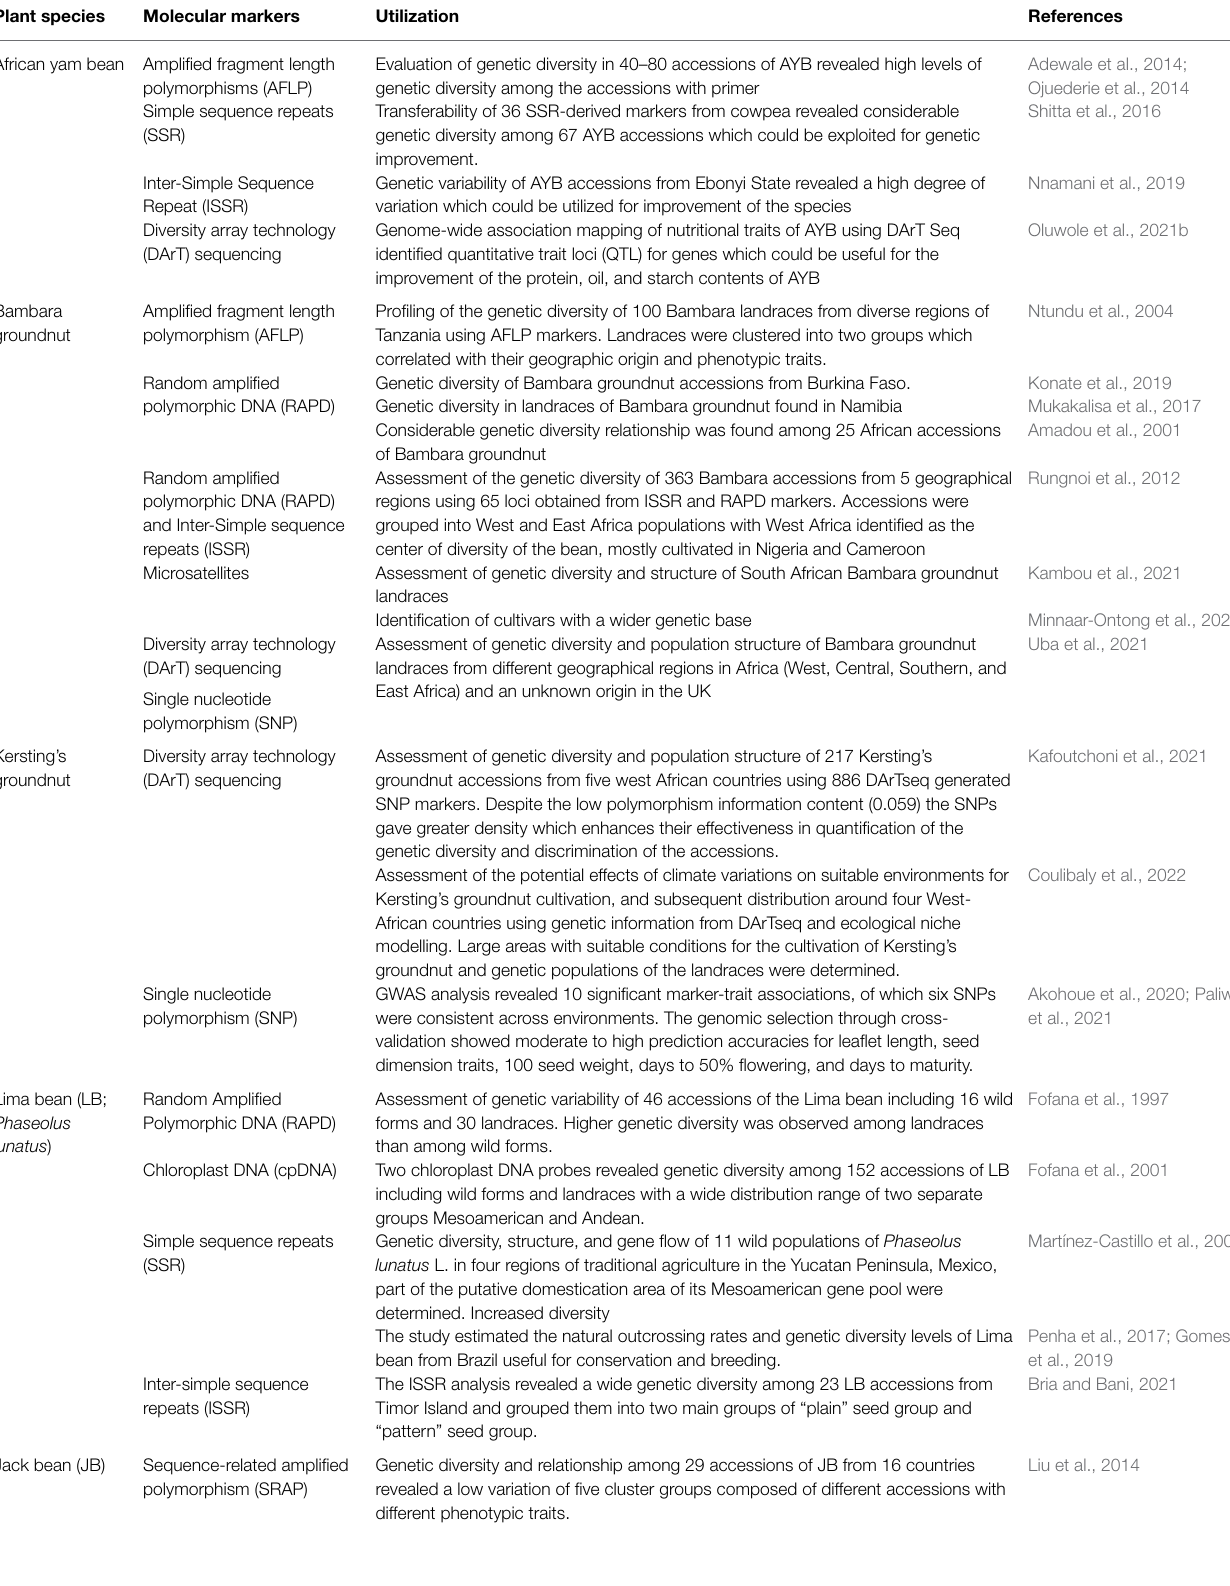
TABLE 6 | Molecular markers used for genetic diversity and population studies in orphan